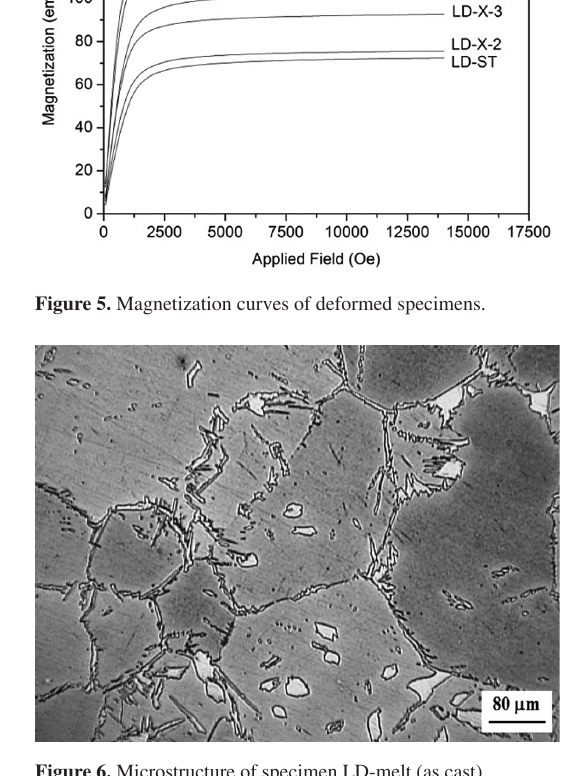
Figure 2. Microstructure of specimen LD ST.